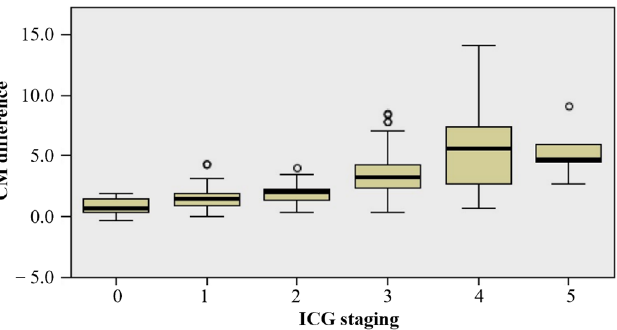
Figure 3. The distribution of CM difference between different ICG stages (ICG, indocyanine green; CM: circumference measurement).